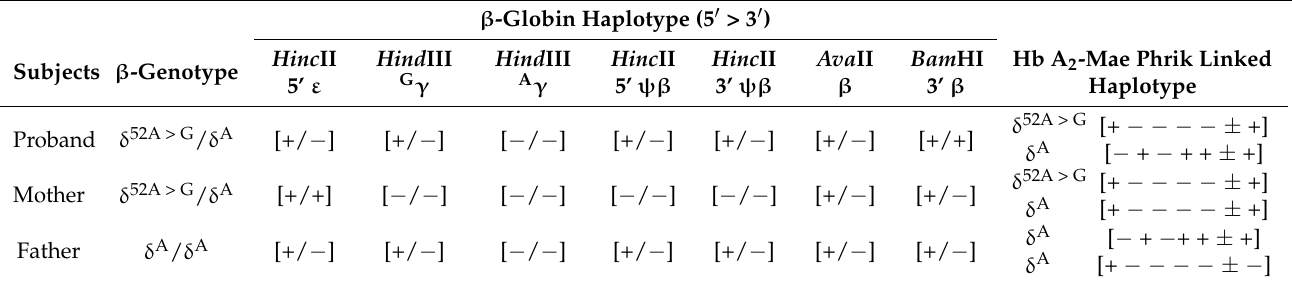
Table 2. β -Globin gene haplotypes associated with Hb A 2 -Mae Phrik in a Thai family. + and − represent the presence and absence of the restriction enzyme sites,